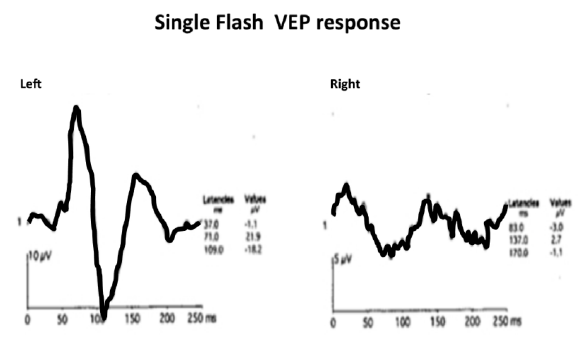
Figure 3: Visual evoked potential with normal P100 amplitude and latency in the right eye and grossly diminished P100 amplitude and latency in the left